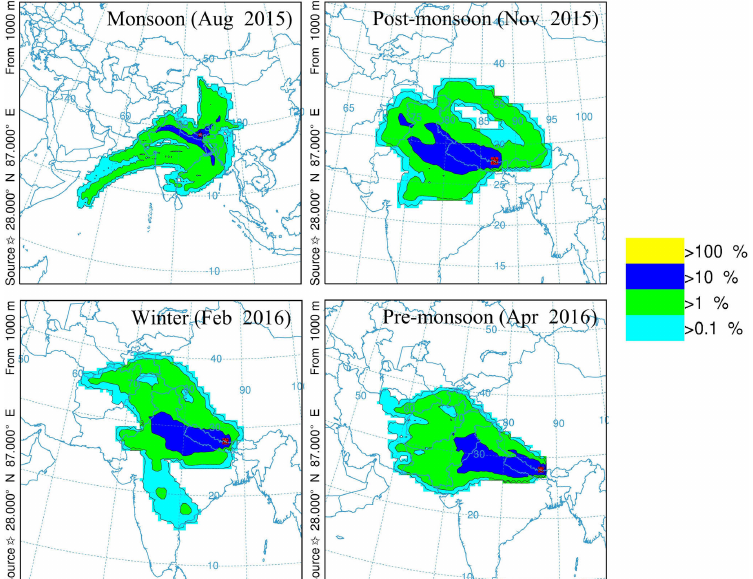
Figure 7. Frequency plots for 5-day backward trajectories calculated by HYSPLIT model at QOMS in different seasons from August 2015 to April 2016.